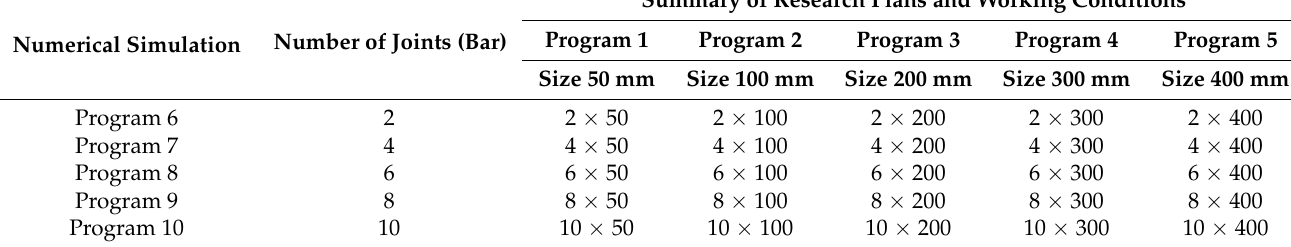
Table 1. Summary of research plans and working